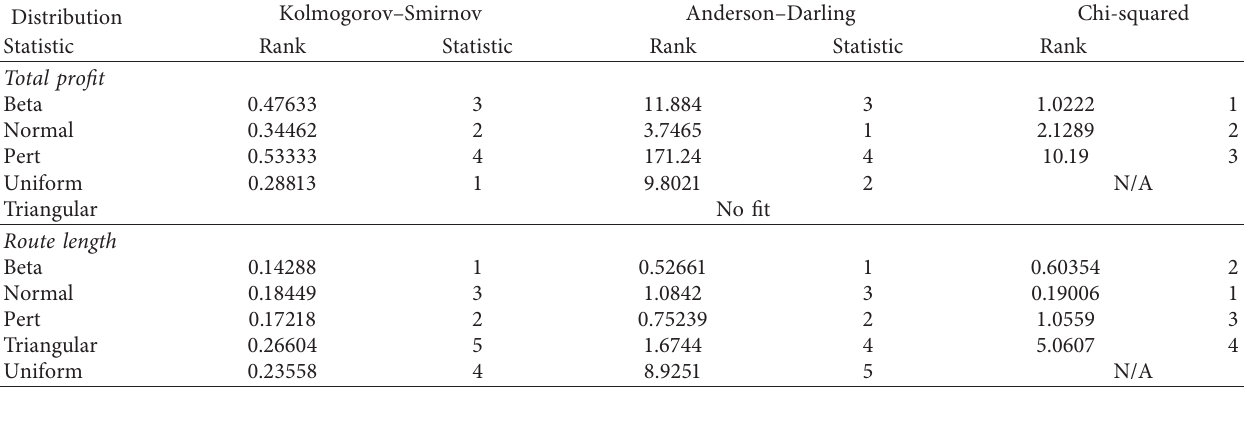
Table 12: Goodness-of-fit summary for the total profit and the route length.